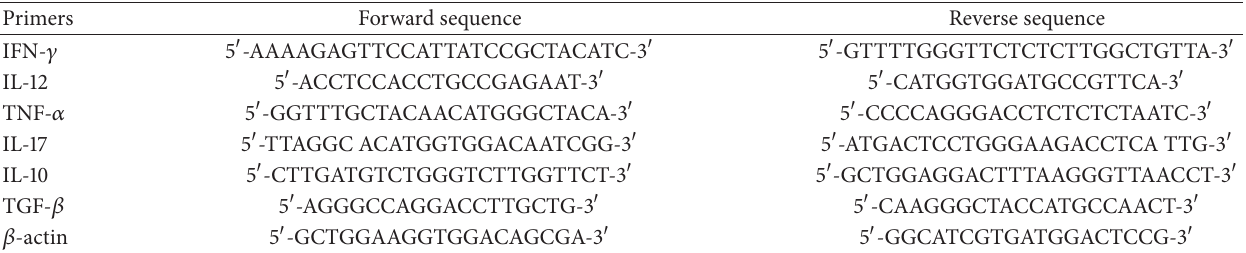
Table 1: Primers sequence for